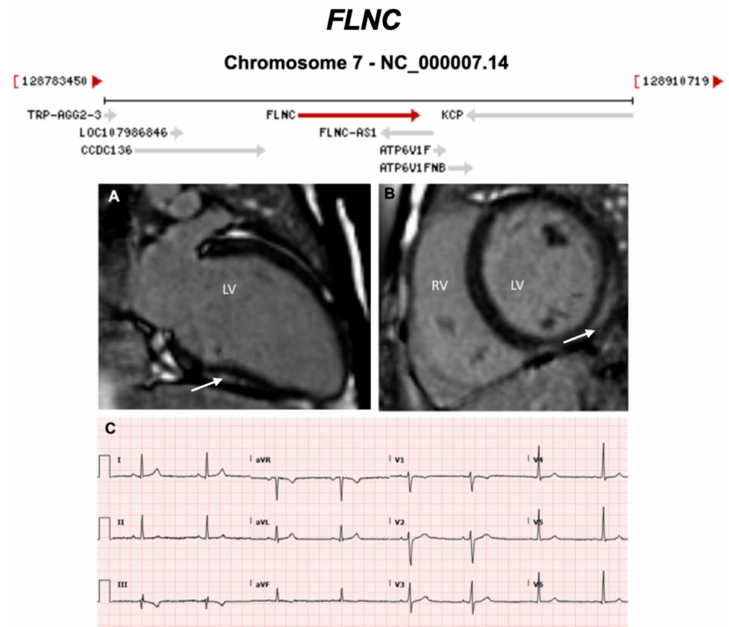
Figure 12. Exemplar MRI and ECG finding found in ACM patients with FLNC mutations. ( A , B ) CMR of a patient with p.Arg991X (nonsense) mutation of the FLNC gene; the arrows show basal lateral subepicardial fibrosis in the LGE mode (white arrows); ( C ) 12-lead ECG of the same patient showing T-wave inversion in III and aVF (inferior leads). Reproduced with permission from Hall et al. (2020) [43].